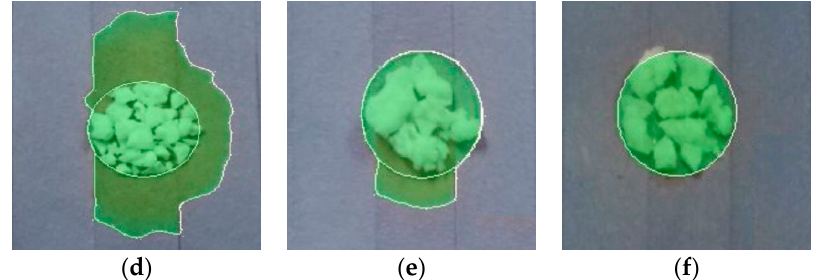
Figure 2. Leakage comparison for sample 3 and calculation of η after the heating: ( a , d ) without coating; ( b , e ) with conformal coating and ( c , f ) with polyacrylic coating.